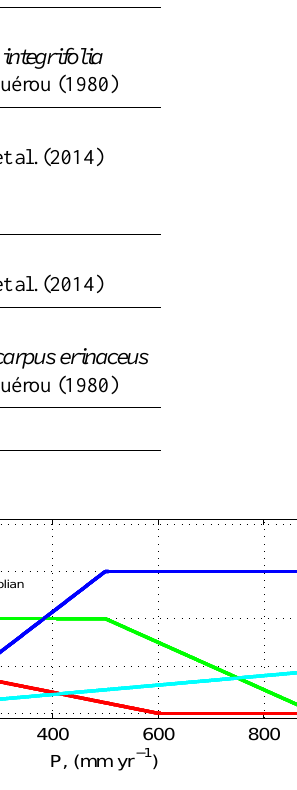
Figure 2. Environmental envelopes in terms of moisture require- ments of four African Humid Period (AHP) plant types in the ad- justed set up. The effective leaf area L i is plotted as a function of mean annual precipitation P for the Saharan type (red), Sahe- lian type (green), Sudanian type (blue), and Guineo–Congolian type (light